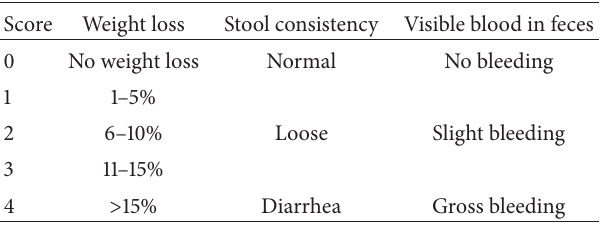
Table 1: Criteria for scoring the Disease Activity Index of IBD (DAI) ∗